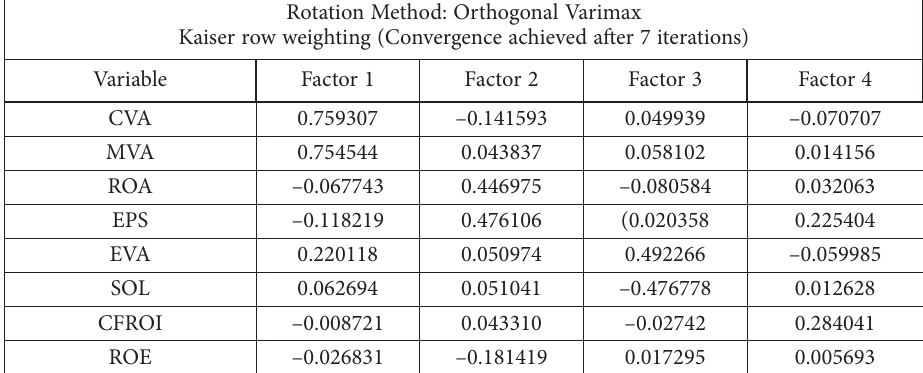
Table 4. Factor matrix (source: authors’ calculation using EViews